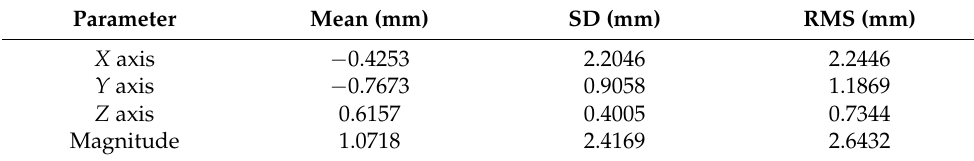
Table 3. Measured error of the EE on the trajectory.